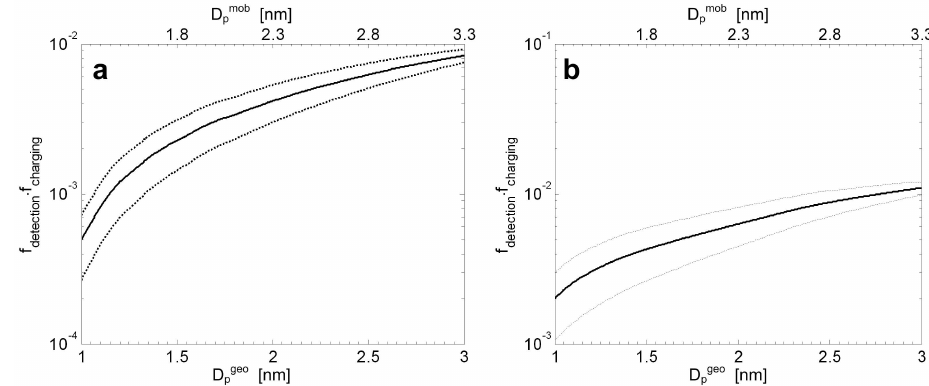
Fig. C1. Upper and lower bound estimates (dotted lines) to the quantity f detection · f charging (the product of size-dependent detection and charging efficiencies) as a function of particle mobility diameter D mob p (upper abscissa) and particle geometric diameter D geo p (lower ab- scissa) obtained for DEG SMPS operation during (a) NCCN and (b) the NCAR campaign. The differences between the two figures arise from differences in the detection efficiency: the DEG UCPC was operated at higher flow rates and super-saturation ratios during the NCAR study. For both campaigns, the same size-dependent systematic relative uncertainty in f detection · f charging was assumed, linearly decreasing from ± 50% at 1nm geometric diameter to ± 10% at 3nm geometric diameter. The solid black line represents the product of the size-dependent detection efficiency of negatively charged NaCl and the bipolar charging efficiency using the parameterization of Wiedensohler (1988). Geometric particle diameters were estimated according to Larriba et al. (2011).